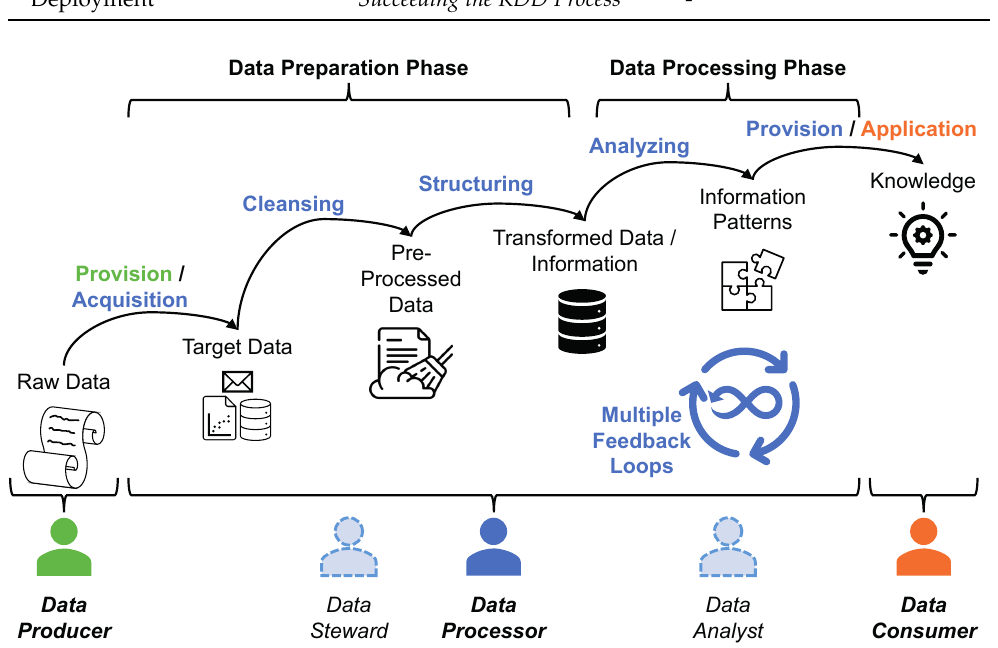
Figure 2. A data refinement process model in accordance with Fayyad et al.